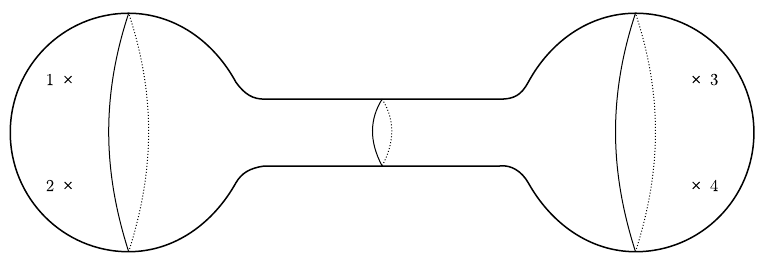
Figure 5. s -channel decomposition of the four-point